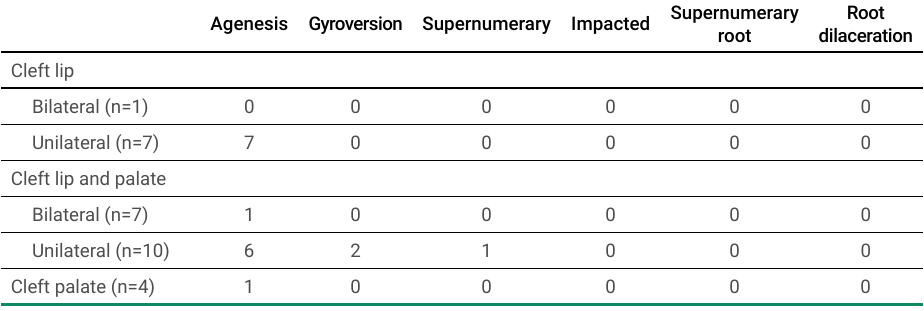
Table 4. Number of dental anomalies by subtype of nonsyndromic oral cleft in the mixed and permanent dentitions. Mixed